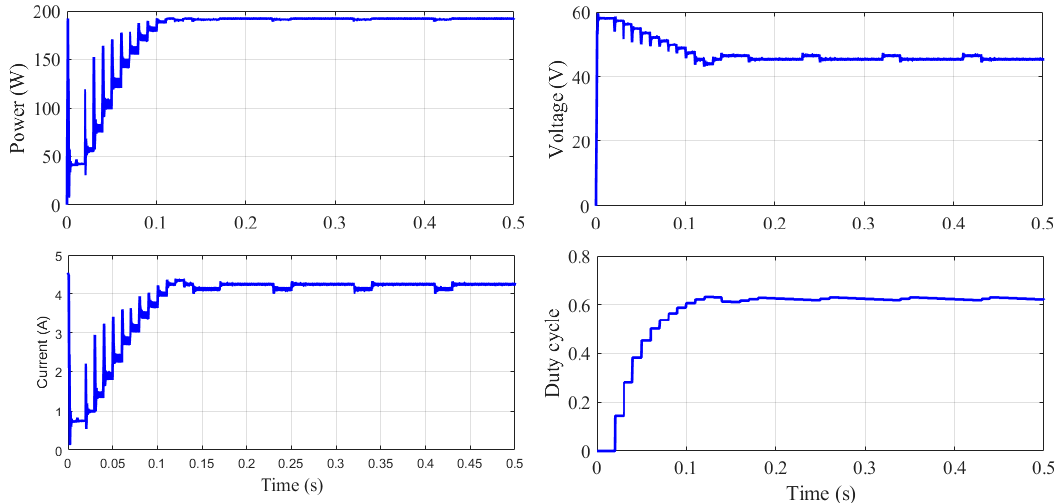
Figure 11. The performance of INC based MPPT under uniform irradiance.